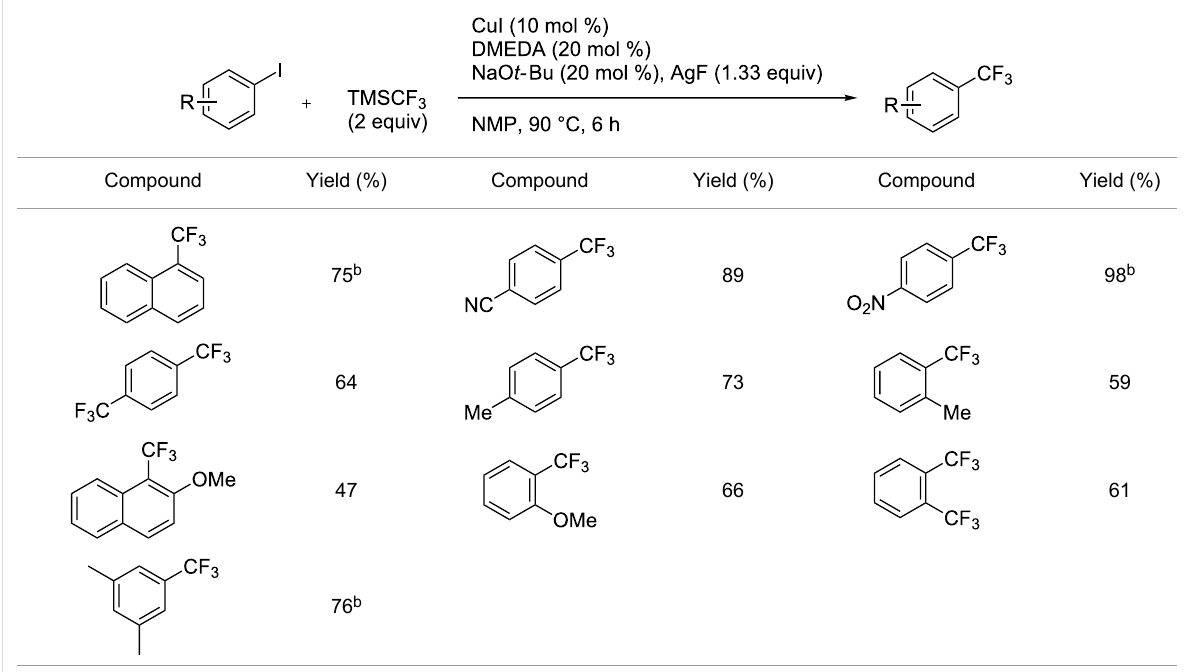
Table 12: Cooperative effect of silver for the copper-catalyzed trifluoromethylation of aryl iodides [73].